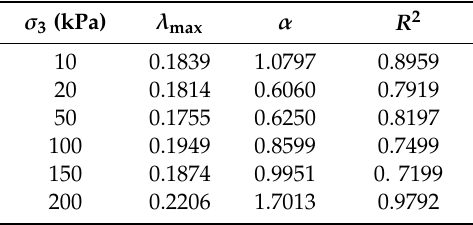
Table 7. Fitted maximum damping ratio and parameter α for various confining